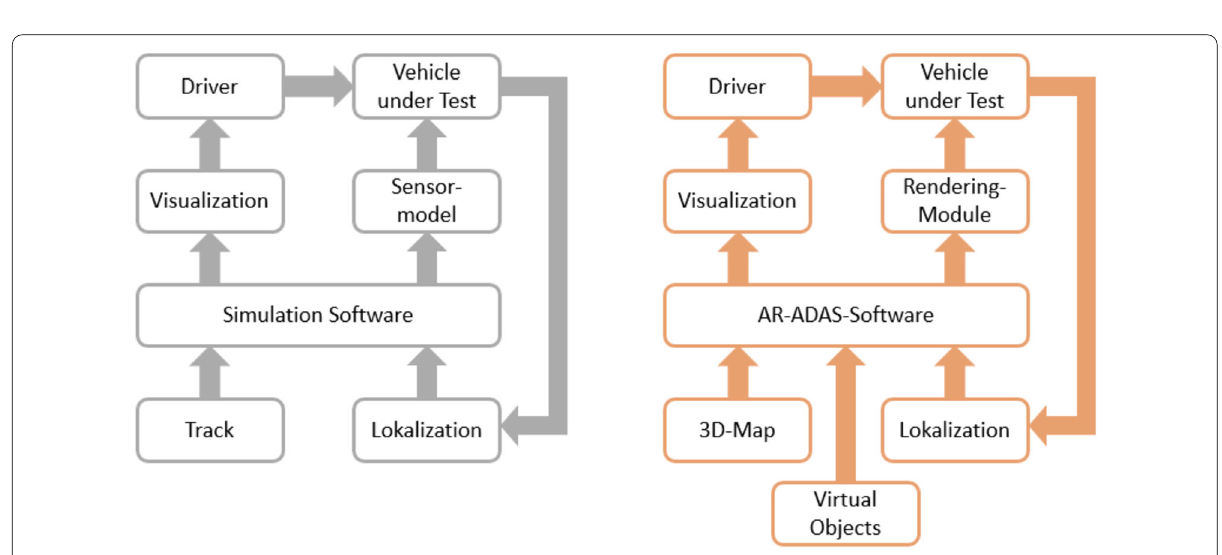
Figure 10 Existing VIL-approach on left side [28] and our approach of using augmented reality in advanced driver assistance systems on the